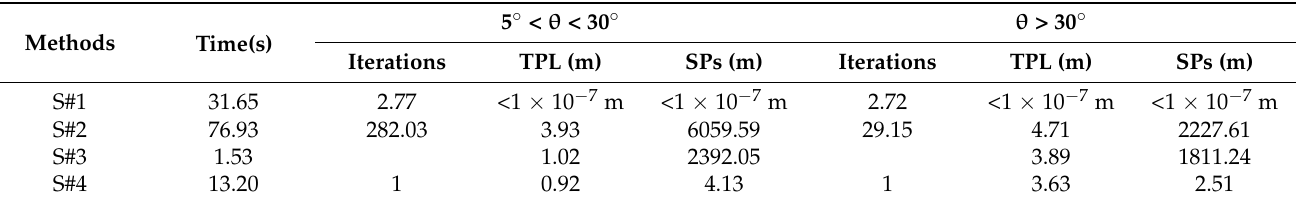
Table 1. Comparisons of the specular point calculation performance among the ellipsoid-based geometry computation strategy (S#1), Minimum Propagation Length iterative method (S#2), and the new empirical initial estimation method presented in Appendix A (S#3). A simplified method (S#4) with only one iteration, based on S#1, is also added in the last